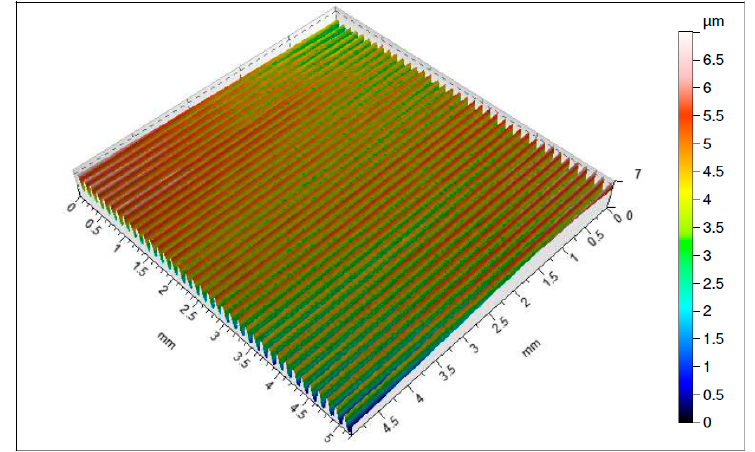
Figure 9. Topography of a surface obtained with an S205-coated cutting insert.